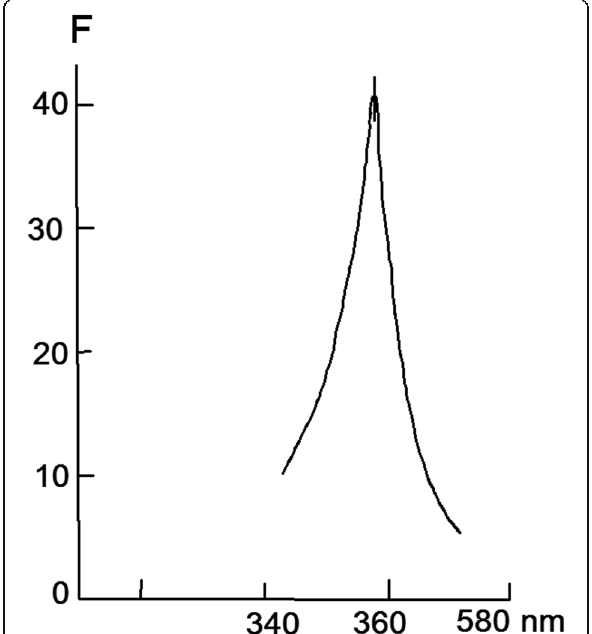
Fig. 3 Optical absorption spectrum of Nox isoforms isolated from erythrocyte (1) and Stevia (2) membranes. Nox isolated from membranes of 10 ml of erythrocytes with a volume of 12 ml and from membranes of 10 g of dry Stevia leaves with a volume of 2 ml. Nox isoforms are dissolved in 0.1 M PPB, pH 7.4 ( p < 0.05, n = 6)